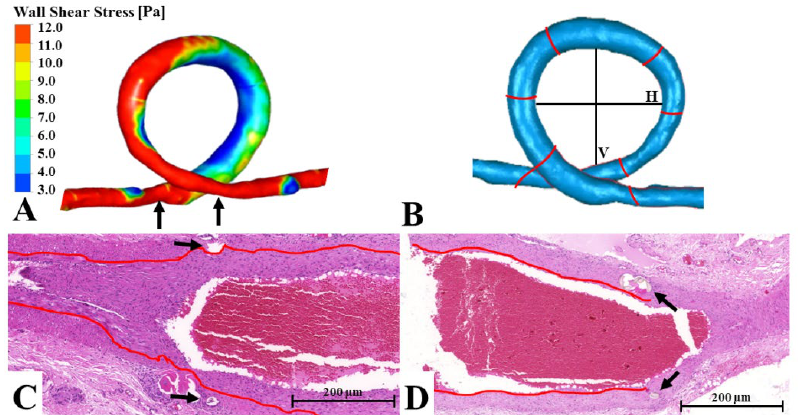
Figure 6. The loop—comparison of the flow simulation and the histology results using a repre- sentative figure. ( A ) Wall shear stress simulation of a freshly performed loop. The left arrow shows the distal anastomosis location, while the right arrow points to the area of the proximal anastomo- sis. ( B ) A 3D model of the loop. The red lines shows where the tissue samples were sliced for his- tology. The black lines V (vertical) and H (horizontal) were used to evaluate the shape change of the loop. ( C , D ) Longitudinal histological slide of the distal and the proximal anastomosis. The red line follows the internal elastic membrane. The arrows show the stitches at the arterio-venous junction. Magnification: 50 × , 70 ×